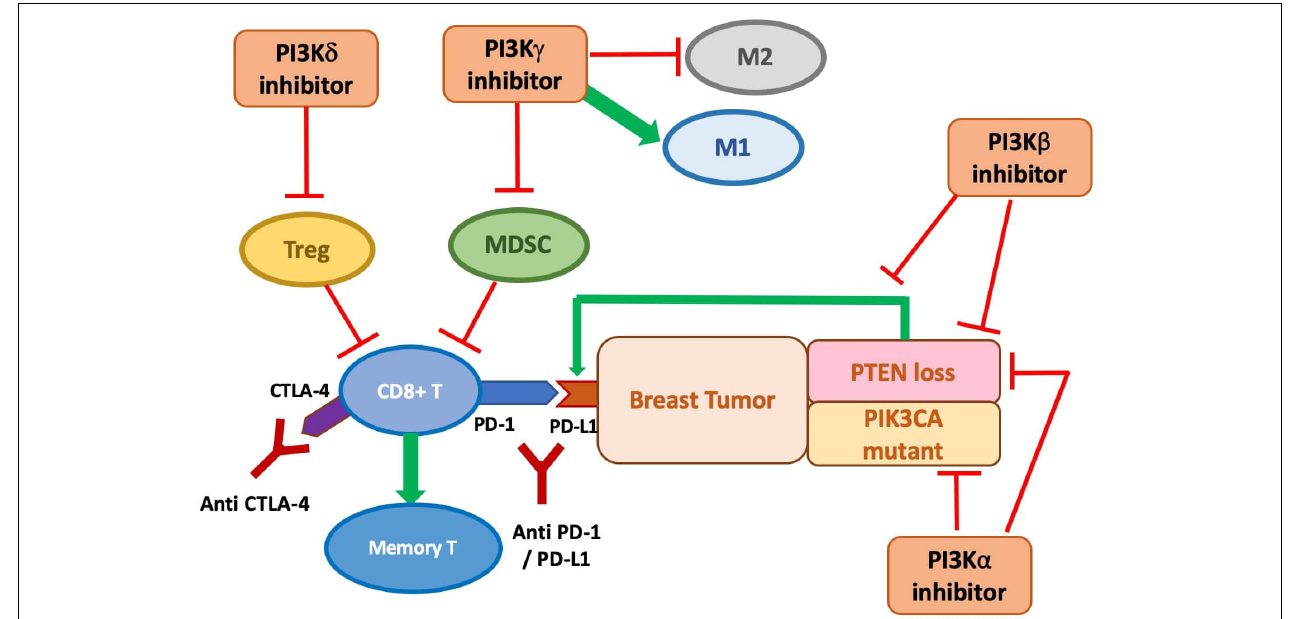
FIGURE 2 | The anti-tumor role of PI3K inhibitors on breast cancer with direct inhibition on cancer cell proliferation and indirect stimulation of the immune response, and potential synergy with immune checkpoint inhibition. PI3K δ inhibitor is shown to suppress Treg function. PI3K γ inhibitor may prevent MDSC infiltration and accumulation and polarize macrophages to the M1 phenotypes. PI3K β inhibition antagonizes the p110 β activity required for PTEN-null tumor and targets the increased PD-L1 expression on PTEN-null tumor. PI3K α inhibition is demonstrated to be effective at preventing tumor cell growth, especially in PIK3CA mutants, but might also be promising in PTEN-null tumor to prevent the PI3K β / α feedback